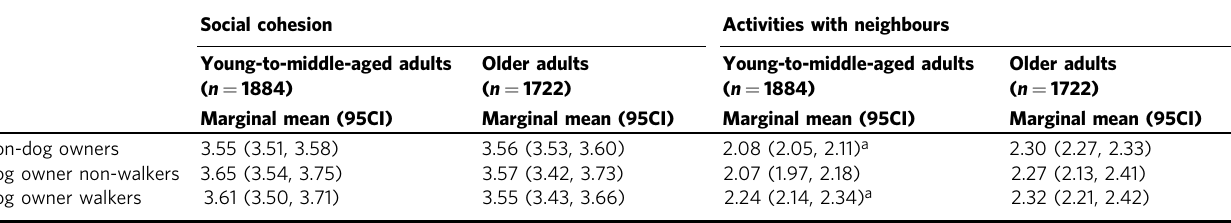
Table 3 Age-strati fi ed adjusted linear regression estimates (marginal means) and 95% con fi dence intervals for differences in social capital scores by dog ownership and dog walking